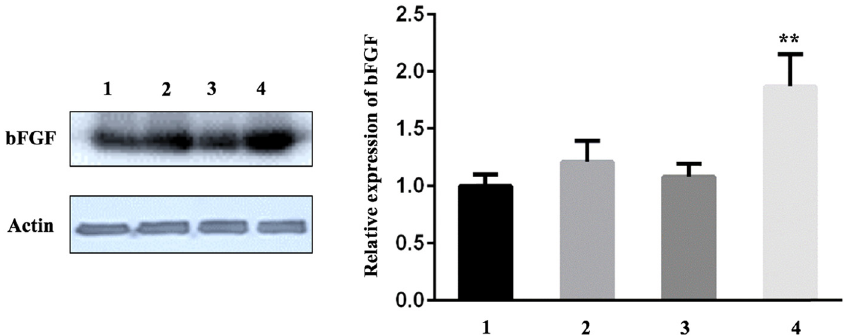
Figure 11: bFGF protein expression in the Achilles tendon of rabbits. Group 1: the control group that received only normal saline; Group 2: the group that received the bFGFp; Group 3: the group that received the microbubbles with the bFGFp. Group 4: the group that received targeted microbubble ( the contrast agent with bFGFp and the target location factor, ICAM - 1 antibody )